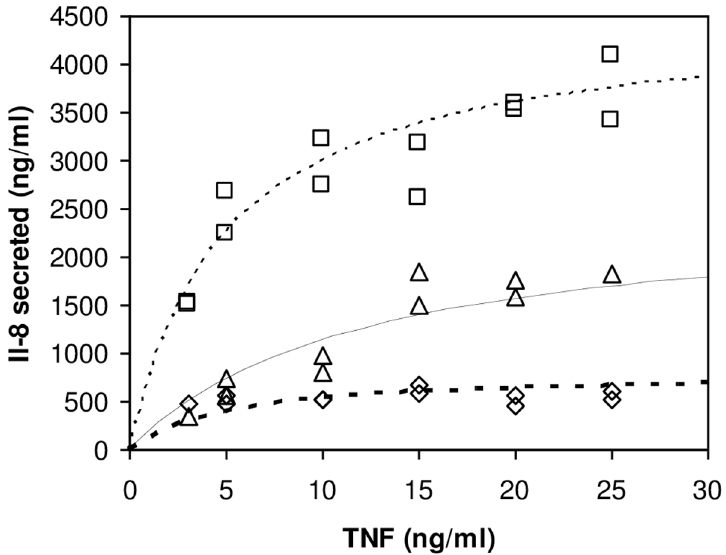
Fig 1. Interleukin-8 production by TNF-treated HT-29 cells. TNF concentration of proinflammatory cytokine IL-8 production after 6-hour [diamonds], 14-hour [triangles], or 24-hour [squares] treatment. The results are expressed as the minimum and maximum values of triplicate of at least 3 independent